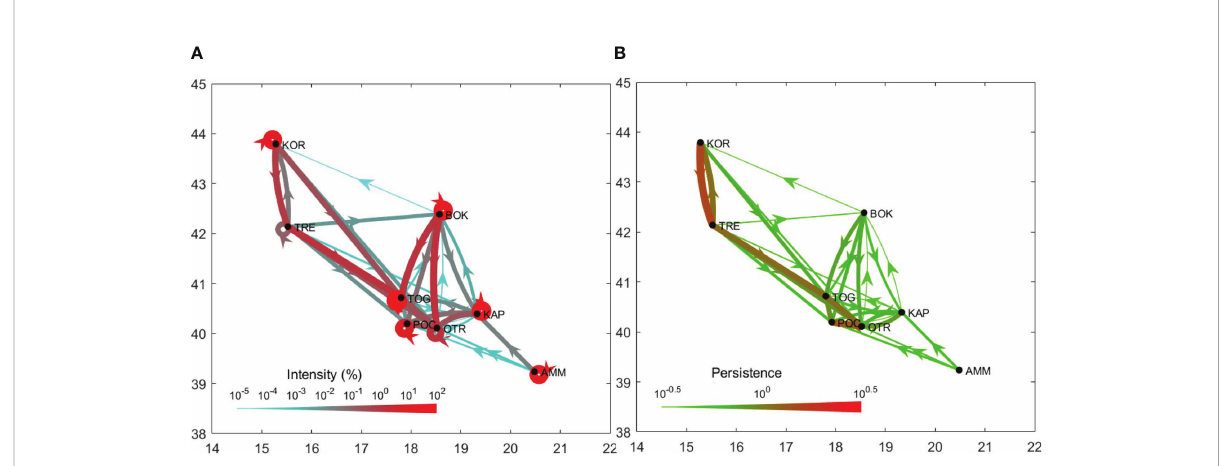
FIGURE 3 (A) Connectivity intensity graph for Pachygrapsus marmoratus . Connectivity intensity (estimated via Lagrangian simulation) is measured as the percentage (averaged across the simulation period) of larvae successfully moving from a site of origin to the destination sites. Loops (i.e. edges connecting a location with itself) indicate local retention. (B) Connectivity persistence graph for Pachygrapsus marmoratus . Connectivity persistence is de fi ned as the stabilization coef fi cient (i.e. the reciprocal of the coef fi cient of variation) of the average annual fl ux of larvae successfully moving from a site of origin to the destination sites, calculated over the simulation period.